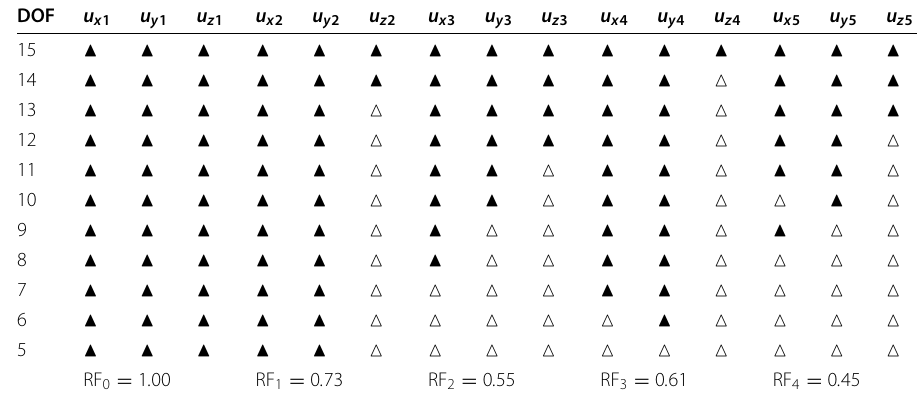
Table 11 BTD models for 0/90/0/90, R/a = 100 , a/h = 10